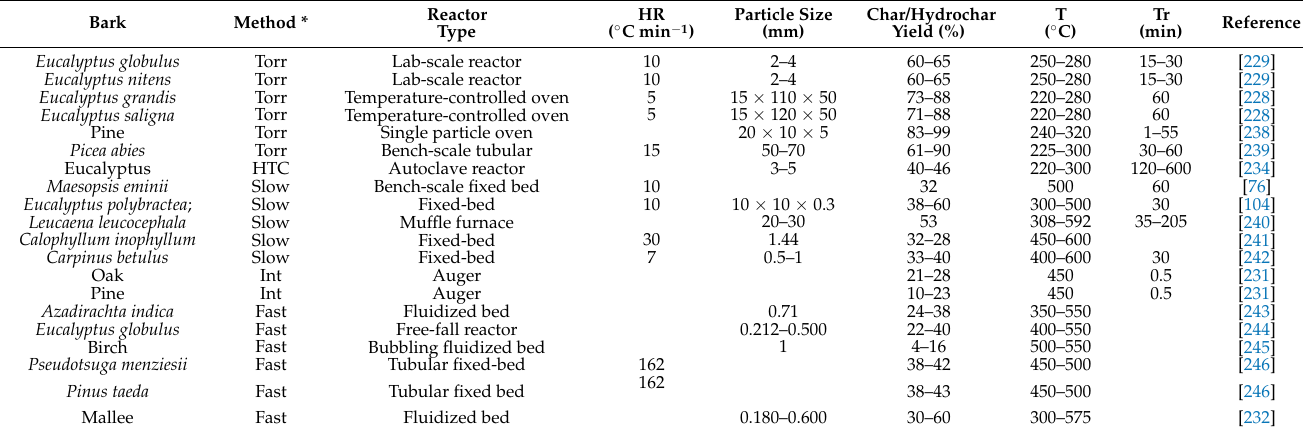
Table 3. Studies on the charcoal production in the last 15 years using bark as a feedstock.